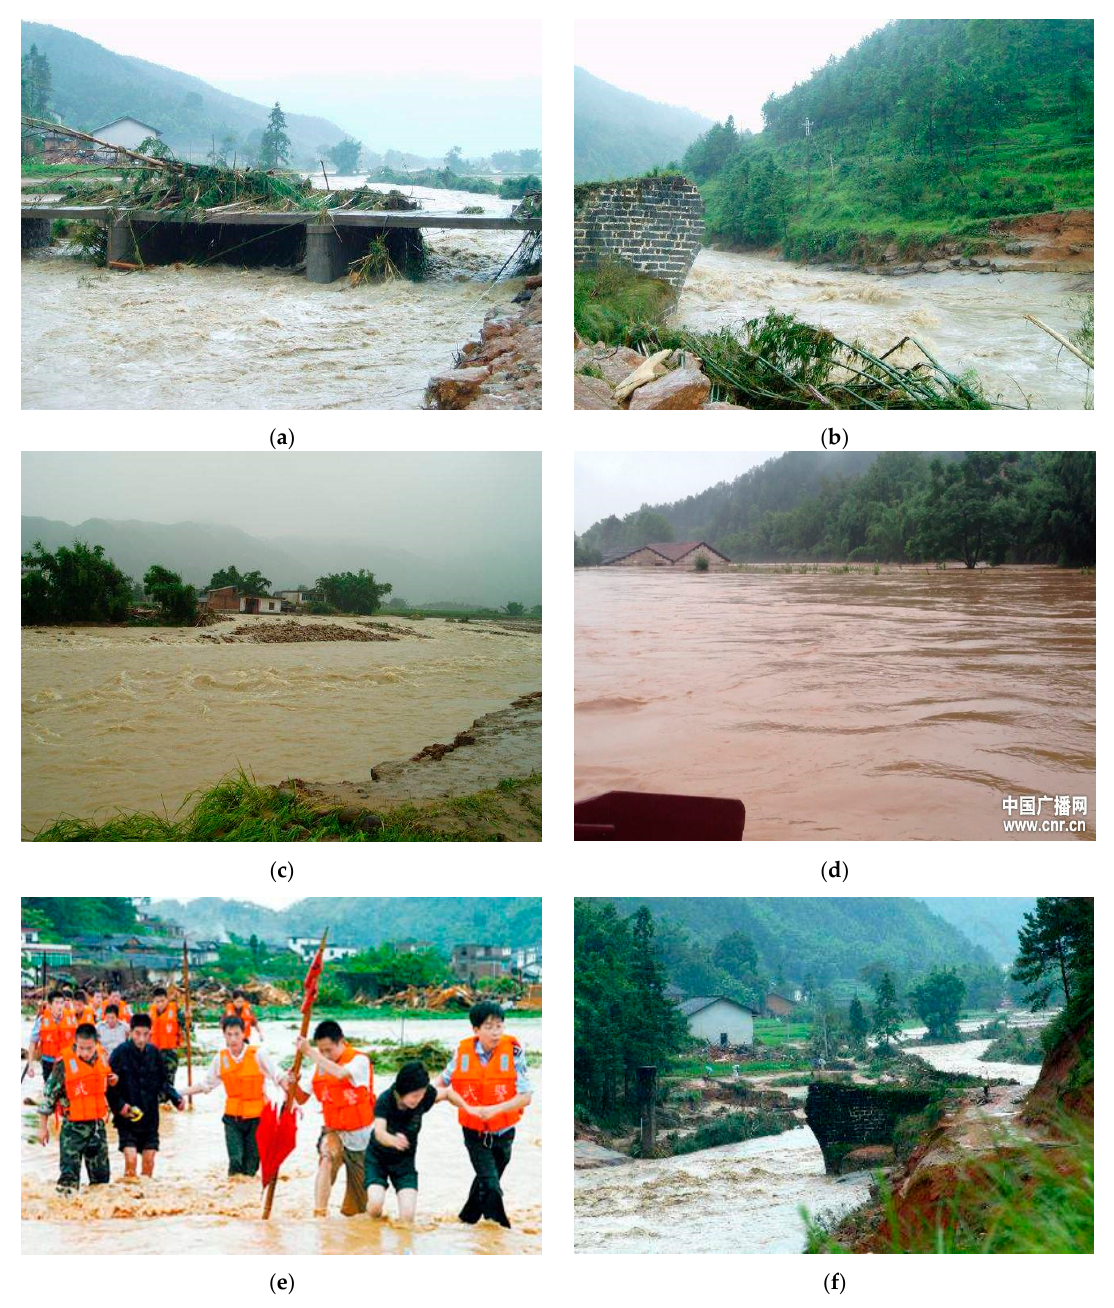
Figure 2. Flood field photos (a-f) of the study area.